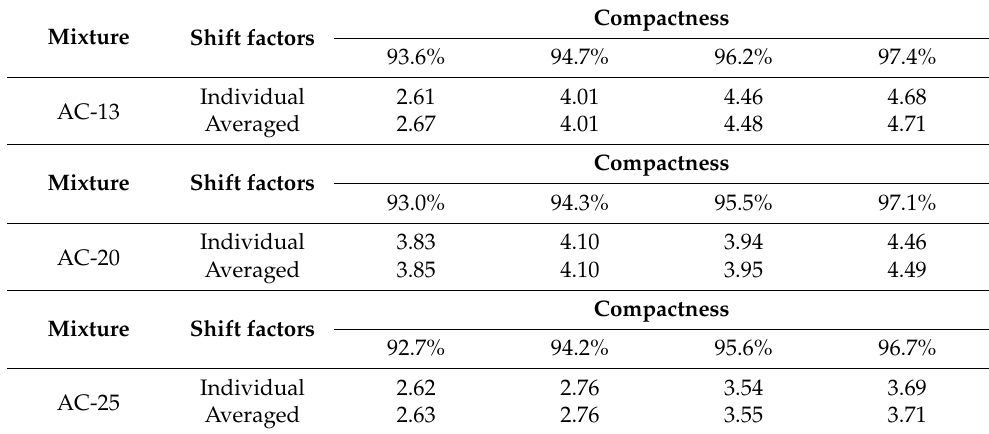
Table 7. The SSR results (%) for the use of individual and averaged shift factors.